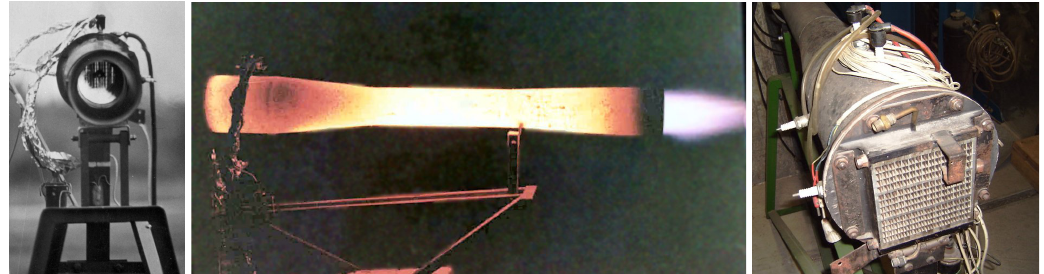
Figure 1. Pulse combustion application: the Schmidt-Argus pulse jet engine in action. Thrust tests led at Thalerhof airport by Zhuber and Pirker in the 1960s (archives TU Graz/TTM) with detail of the Reed air valve and ignition